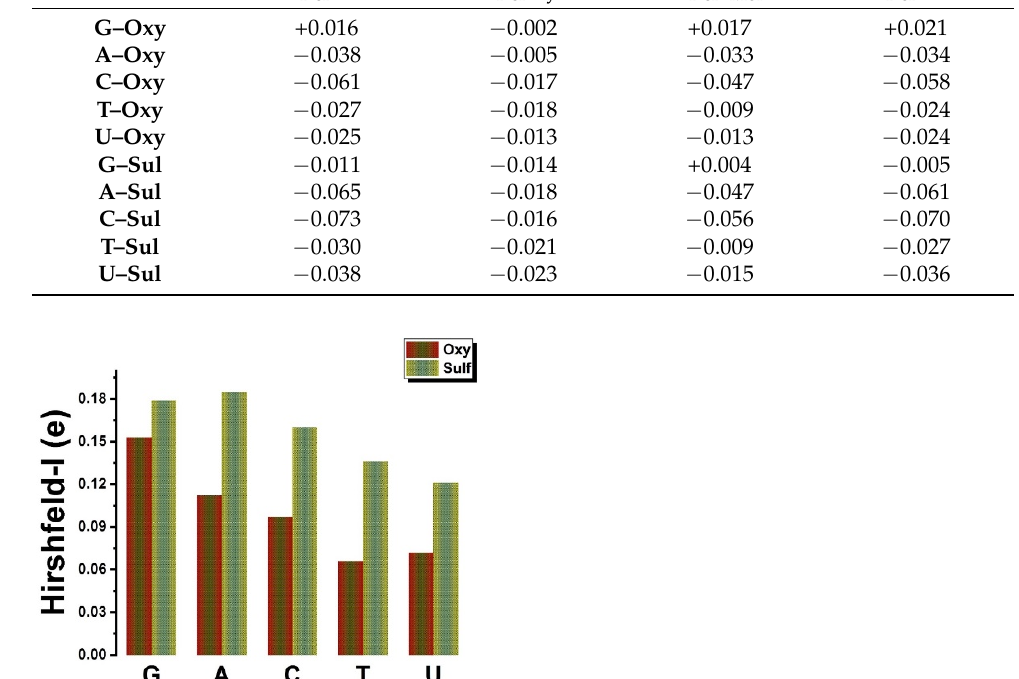
Table 2. The deformation energy of DNA (RNA) molecules on the Janus MoOS of both oxygen (Oxy.) and sulfur (Sul.) layers, deformation energy of total system E Def–Tot , monolayer surface facets E Def–Lyr , nucleobases molecule E Def–Mol , and covalently energy E Def–Cov (All in eV), respectively. Ads. State